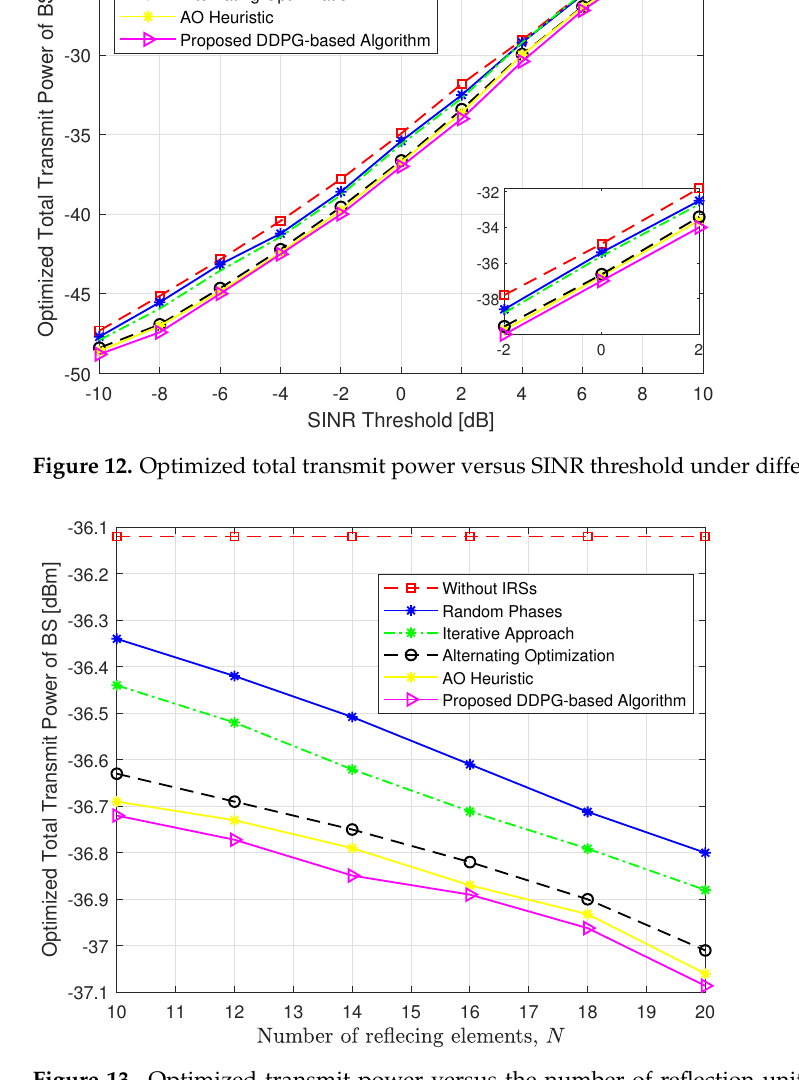
Figure 13. Optimized transmit power versus the number of reflection units for each IRS under different